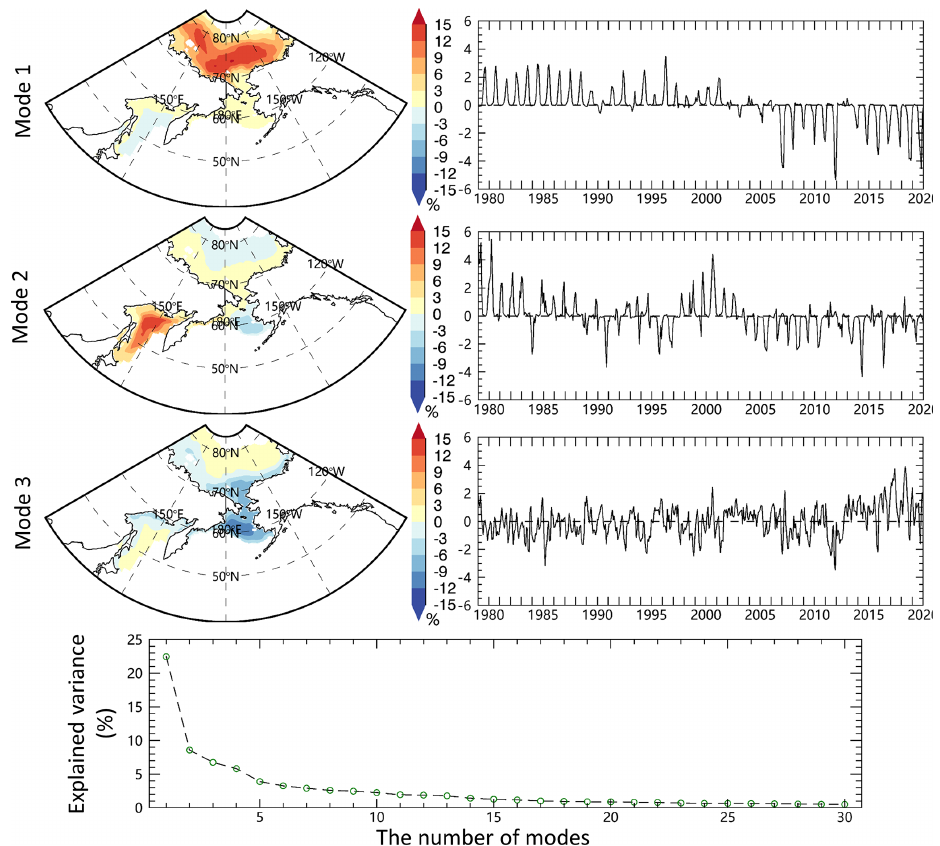
Figure 2. The eigenvectors and PCs of the three leading EOF modes of SIC in the Pacific-Arctic sector for the period 1979–2020. The bottom panel shows the explained variance as a function of the number of leading modes of